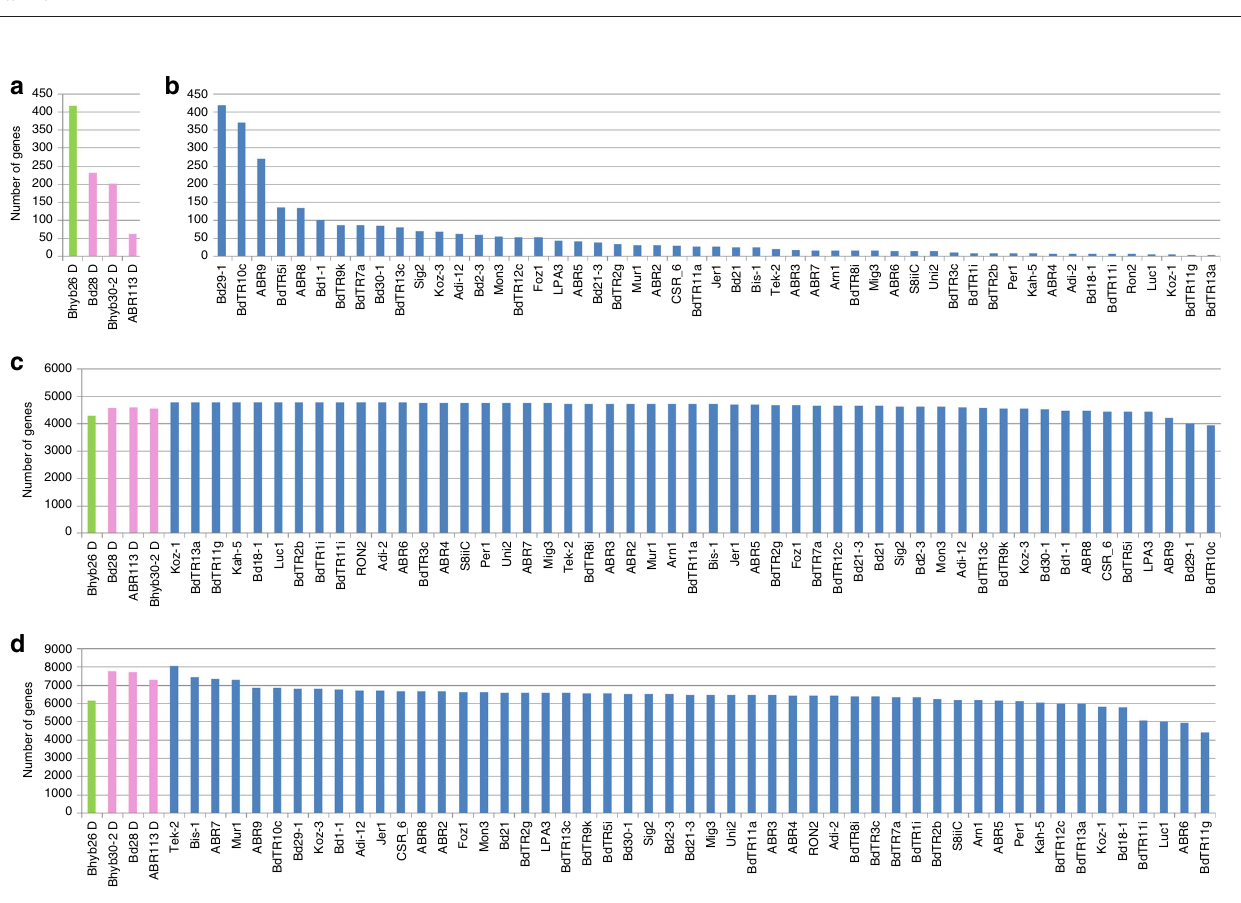
Fig. 7 Comparative pan-genomic analysis. Comparison of the B. hybridum D subgenomes to the B. distachyon pan-genome. a The number of genes that were found in all 52 B. distachyon lines (core genes with respect to B. distachyon ) that were missing from each D subgenome. b The number of genes that were missing from each respective B. distachyon line but present in all other lines. These genes would have been core genes if that particular line had not been used to create the pan-genome. c The number of soft-core genes (found in 54 – 52 of all genomes/subgenomes) in each line. d The number of shell genes (found in 51-3 of all genomes/subgenomes) in each line. The B. hybridum D-plastotype Bhyb26 line is indicated in green, the B. hybridum- S plastotype ABR113, Bhyb30, and Bd28 lines in pink, and the B. distachyon genomes in blue. Note that the B. hybridum D subgenomes values fall within the B. distachyon genomes values. Source data are provided as a Source Data fi